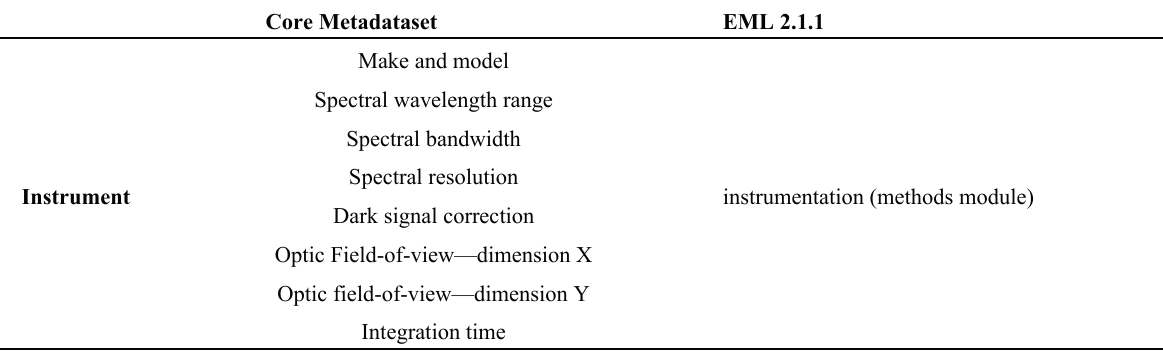
Table A5. Mappings from Ecological Metadata Language 2.1.1 to the Core